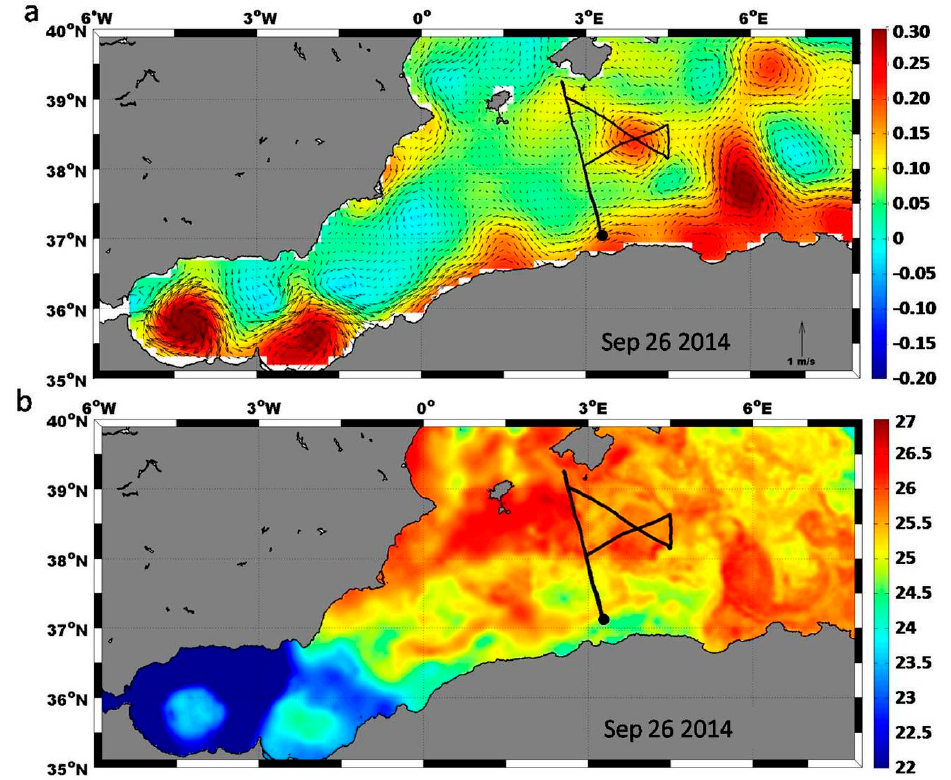
Figure 6. ( a ) All-sat-merged AVISO Absolute Dynamic Topography (ADT) and ( b ) ultra-high-resolution Sea Surface Temperature (SST) maps of the Alboran Sea and the Algerian Basin on 26 September 2014; geostrophic currents are represented through black arrows. Glider track in black. Large black dots represent glider location on each date. ADT in meters, SST in °C.